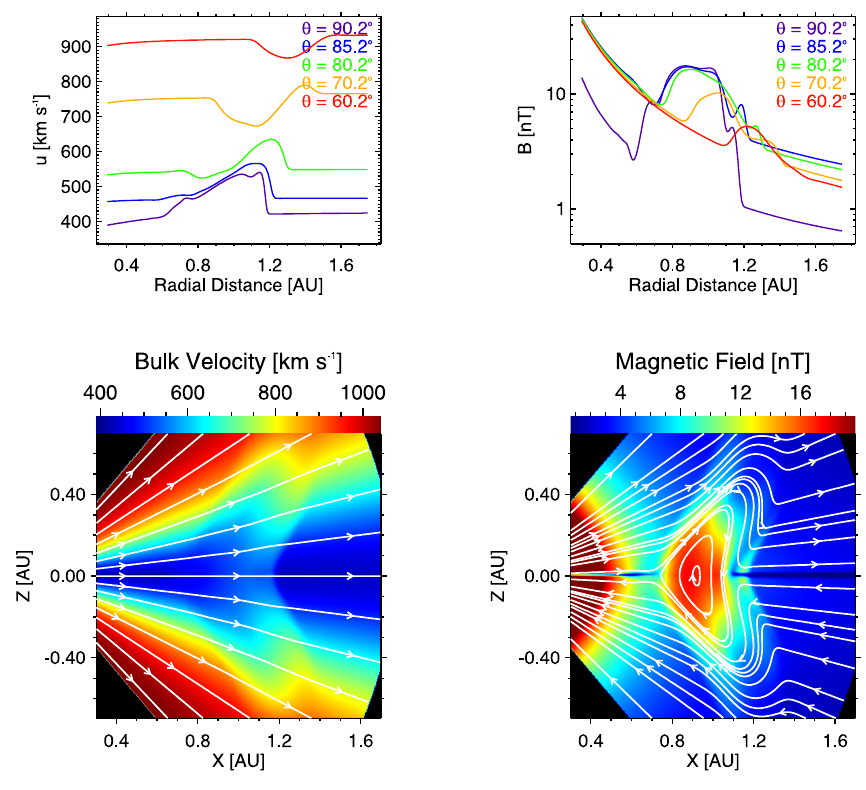
Fig. 10. Distributions for velocity (bottom left) and magnetic field (bottom right) for the H − m magnetic cloud at the distance of Earth (MC- center at ∼ 0.91AU). Corresponding radial profiles at constant polar angels are shown in the top row. Velocity streamlines and magnetic field lines are over-plotted in white color,